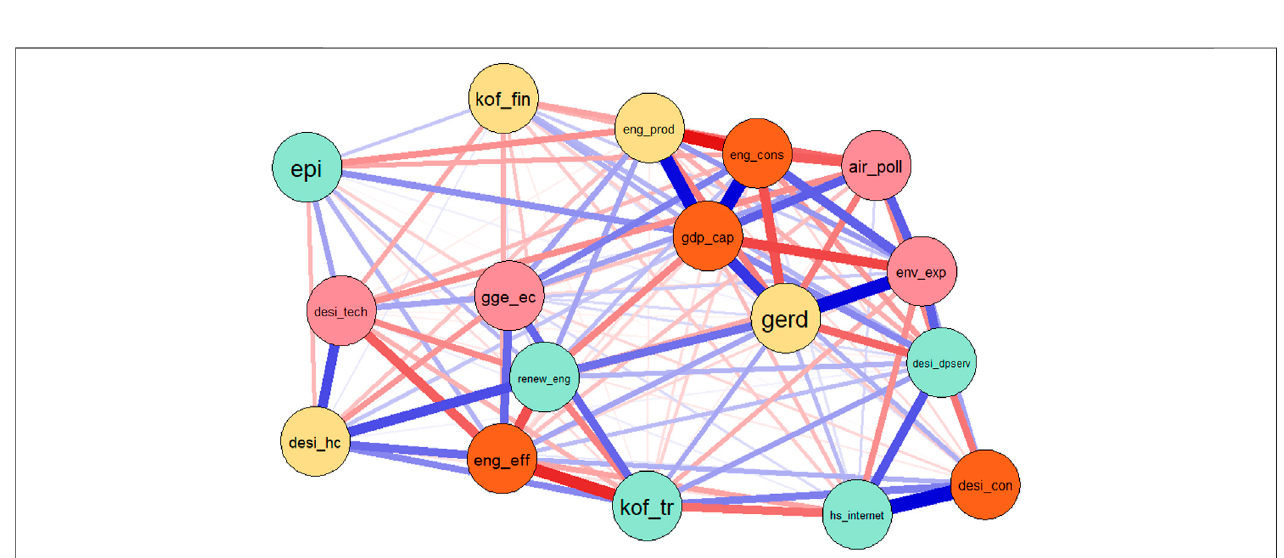
FIGURE 3 | | Gaussian graphical model, partial correlations, EU-27 MS, 2018. Source: Authors ’ research.